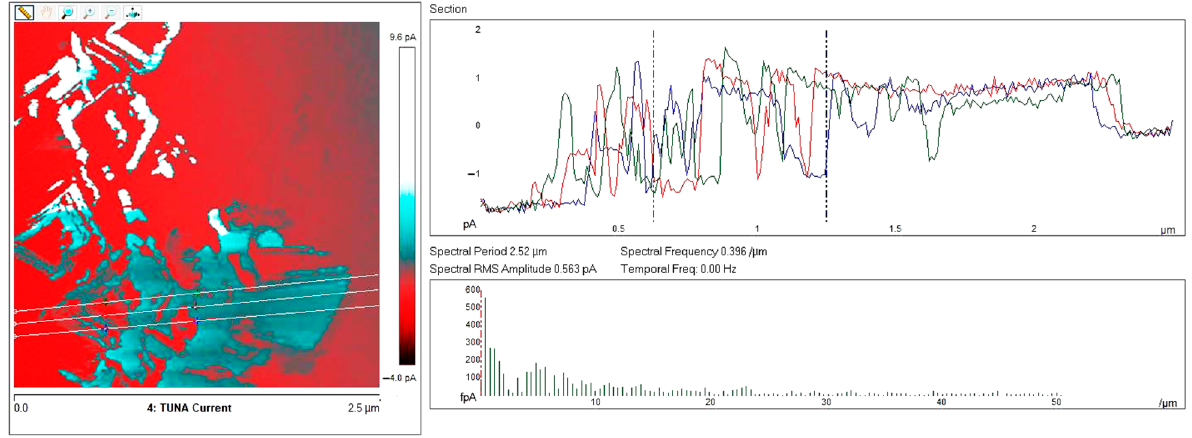
Figure 13. From left to right, TUNA Current picture and current variation profile of the sample TCTBD+0.5%MWCNT-t.